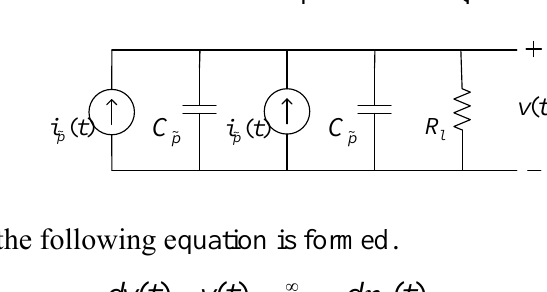
Figure 10. Piezoelectric sensor circuit representation (parallel circuit